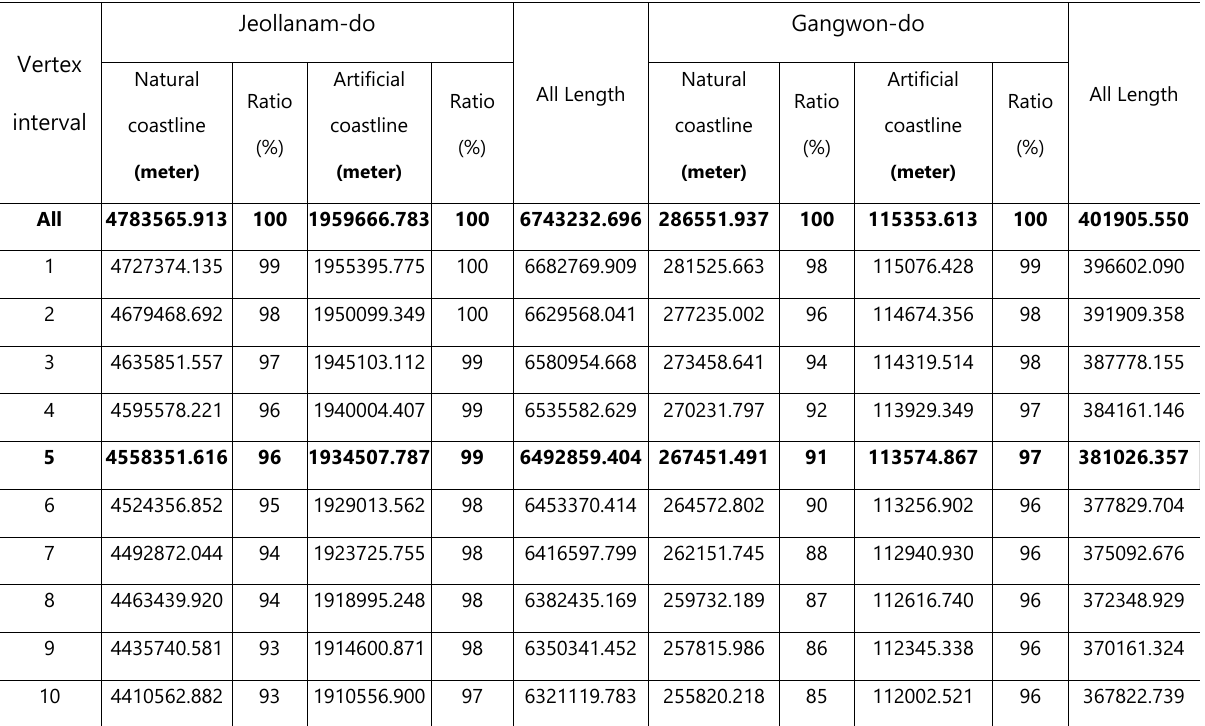
Table 3. Results for generalization of Jeollanam-do & Gangwon-do [1m~10m